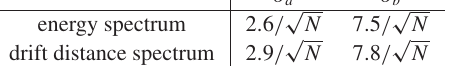
Table 1. Statistical sensitivity of the electron and proton energy spectra on a and b [40] in comparison with the drift distance spectra in the standalone case. N represents the number of measured electrons or protons. energy spectrum 2 . 6 / drift distance spectrum 2 . 9 / no additional fit parameters, one day of drift distance measurement yields a statistical uncertainty of σ b ≈ 8 × 10 − 4 and σ a / a ≈ 0 . 28%, respectively. Adding